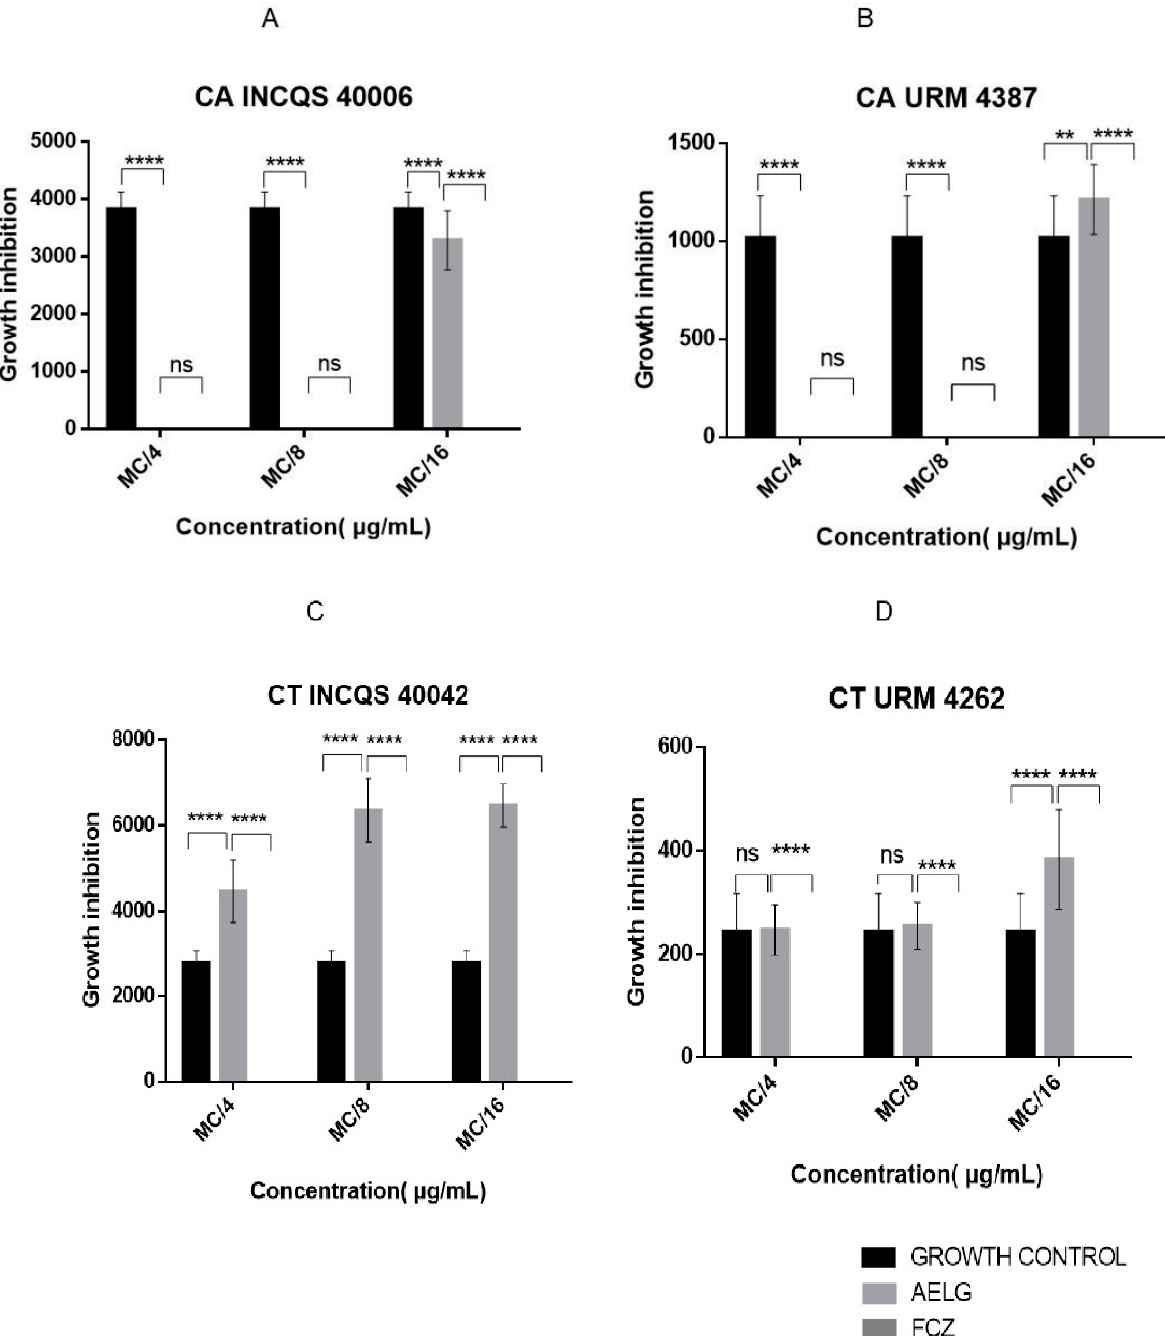
Figure 6. Effects of G. hirsutum aqueous extract and fluconazole on the morphological transition of Candida albicans INCQS 40006 ( A ), Candida albicans URM 4387 ( B ), Candida tropicalis INCQS 40042 ( C ) and Candida tropicalis URM 4262 ( D ). MC: Matrix Concentration (16.384 µ g/mL); MC/4: 4.096 µ g/mL, MC/8: 2.048 µ g/mL, MC/16: 1.024 µ g/mL; Growth inhibition—measured by micrometer-sized hyphae ( µ m); No bar—no hyphae growth. ** = p < 0.01, **** = p < 0.0001, ns = No